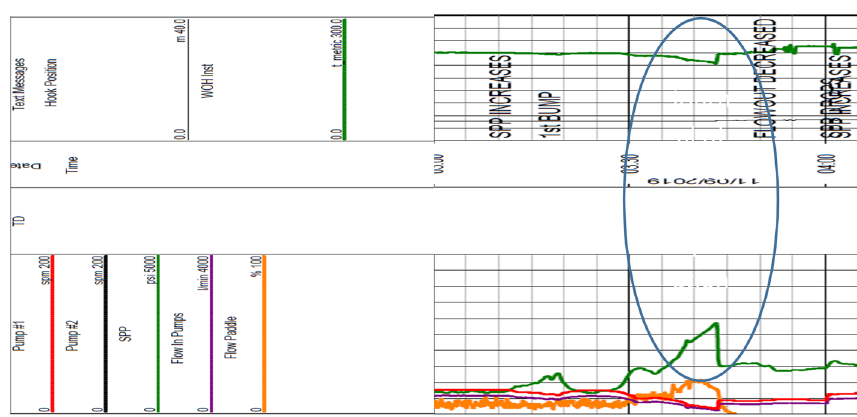
Fig. 2 9 ″ 5/8 displacement